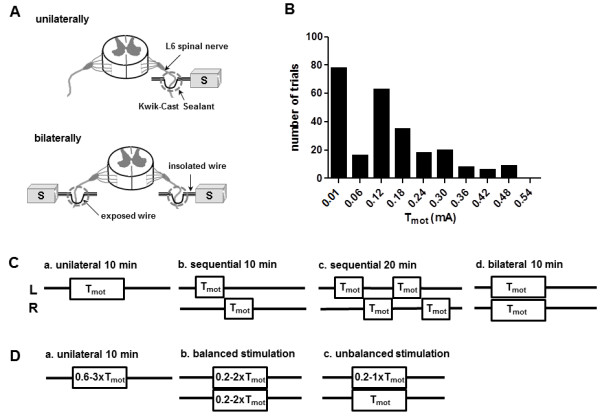
Experimental model for spinal nerve stimulation. A. Experimental setup and location of unilateral and bilateral electrode implantations. B. Histogram of motor threshold (Tmot) to spinal nerve stimulation. C and D. Schematic drawings of the stimulation trials of unilateral or bilateral neuromodulation at Tmot intensity (C) and intensity dependent effects of spinal nerve stimulations (D). Unilateral stimulation was delivered on the left (L) side of the spinal nerve and bilateral stimulation was applied simultaneously on both left and right (R) side of the nerve.